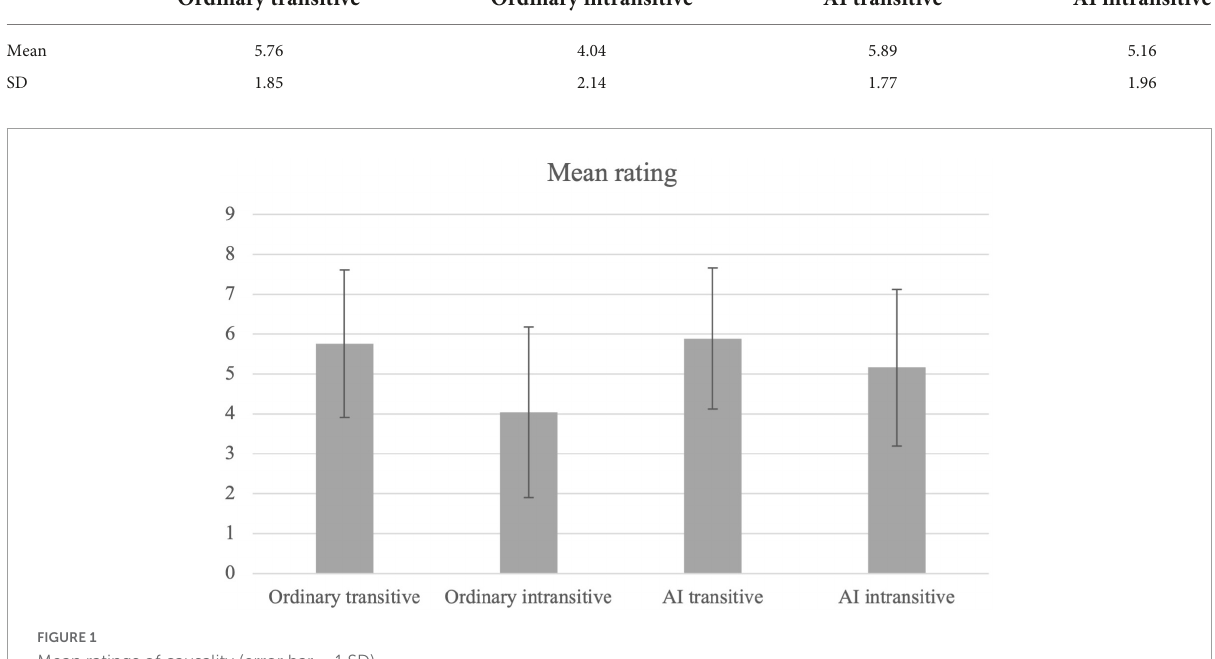
FIGURE1 Mean ratings of causality (error bar = 1 SD).